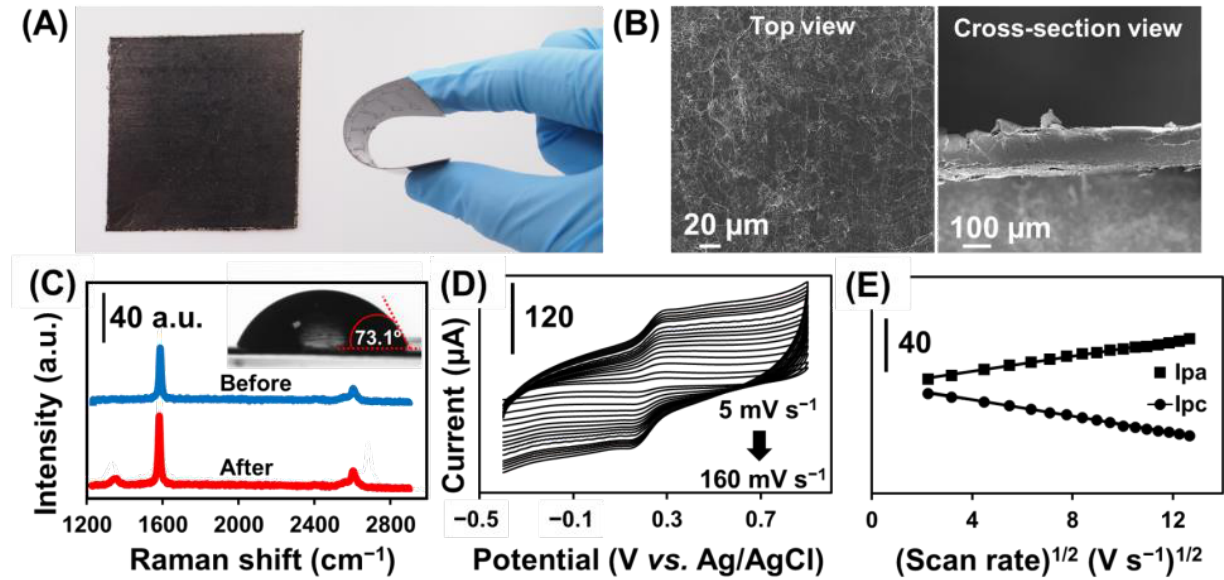
Figure 2. ( A ) Photograph of GPE and the bending of GPE attached to the PET sheet. ( B ) SEM image of GPE at the top view (left) and cross-sectional (right) view. ( C ) Raman of GPE before and after plasma treatment and contact angle of GPE after plasma treatment (Inset). ( D ) Cyclic voltammograms with different scan rates from 5 to 160 mV s −1 in 0.1 mol L −1 KCl containing 2 mmol L −1 [Fe(CN) 6 ] 3−/4− at GPE. ( E ) Plots of the Ipa and Ipc versus the square root of scan rates (from 5 to 160 mV s −1 ) at GPE.